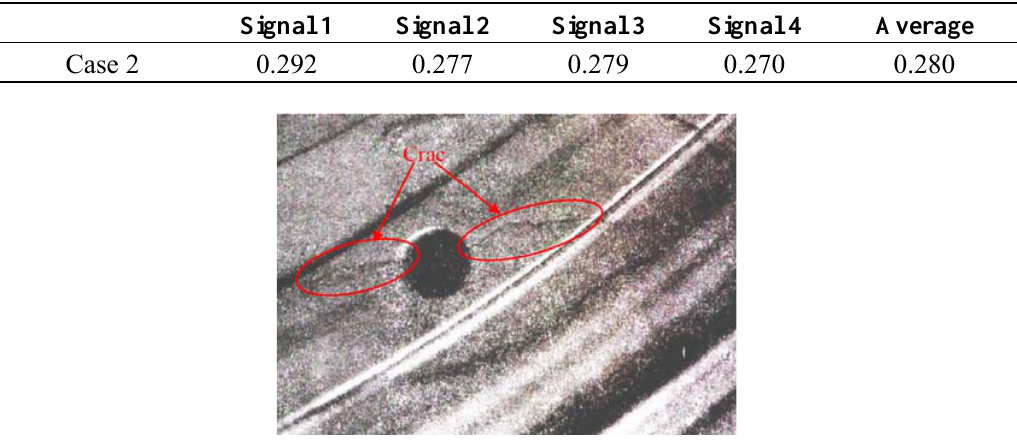
Table 2. The normalized ensemble multiwavelet transform information entropy of the aero-engine rotor in case 2.